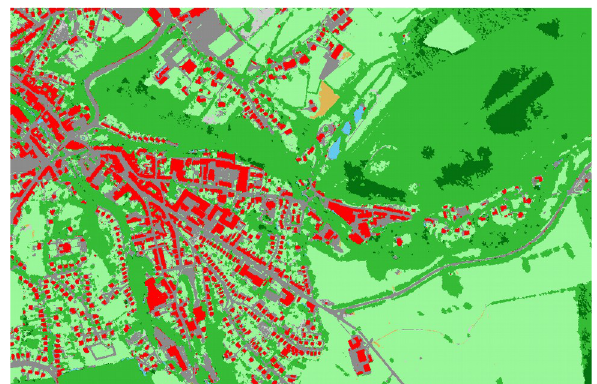
1)Figure 6: Original